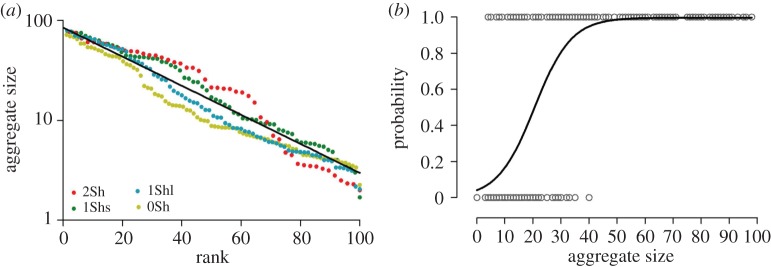
(a) Distribution of aggregate size (mean number of individuals included in the aggregate during its lifetime) during the experiments according to the set-up. Logarithmic scale for the y-axis. The solid line represents the mean exponential fitting of the pooled data Y =a.e−bX with a=85.1 (±0.565) and b=−0.033 (±0.000319) (d.f.=270; R2=0.9876). (b) Probability that an aggregate will be present (=1) or dislocated (=0) at the 45th minute according to the maximum size (maximum number of aggregated individuals inside) reached during the experiment. The data are fitted by a logistic function y=a/(1+e−c(x−T)) (R2=0.4616).